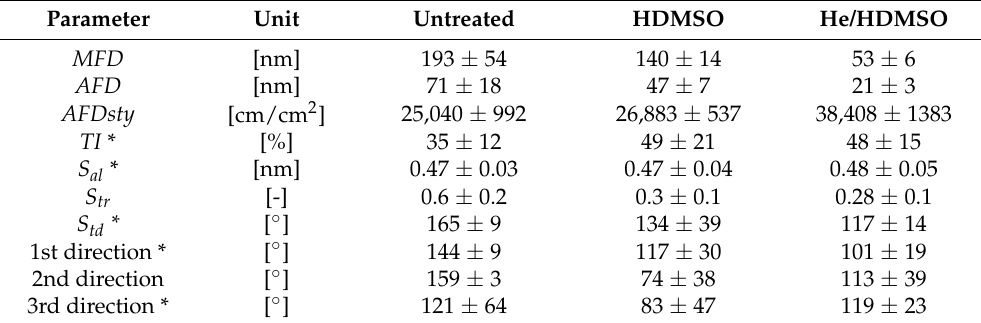
* Samples without significant difference after one-way ANOVA ( p <